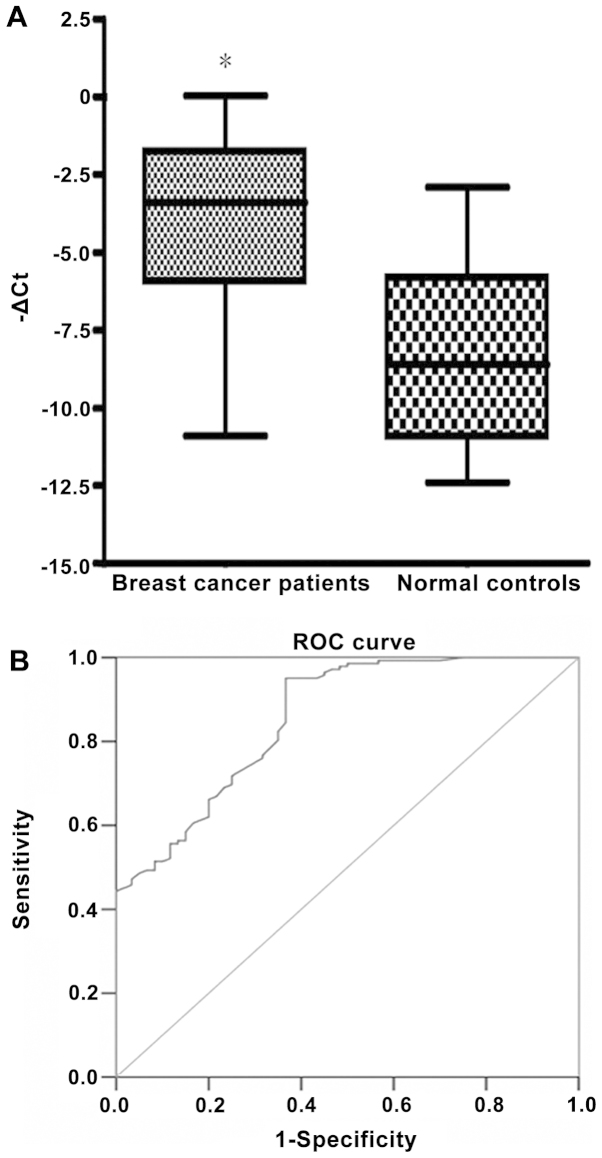
(A) Expression levels of the neuropeptide Y receptor Y1 (NPY1R) gene in the peripheral blood of breast cancer patients compared with normal controls. *P<0.01. (B) Receiver operating characteristic (ROC) curve of the NPY1R marker gene. Area under the curve, 0.855.